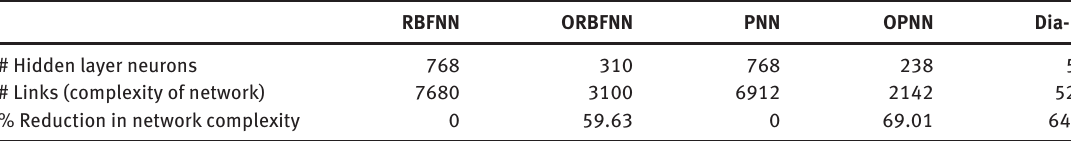
Table 4: Comparison of the proposed method with other RBFNN variants of the same domain.